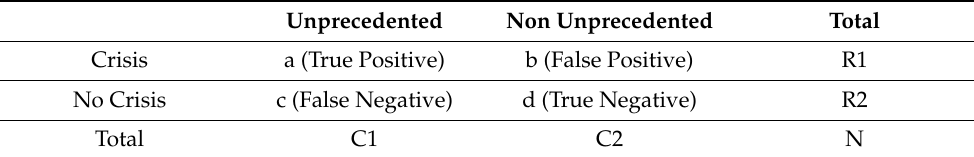
Table 1. The 2 × 2 contingency table